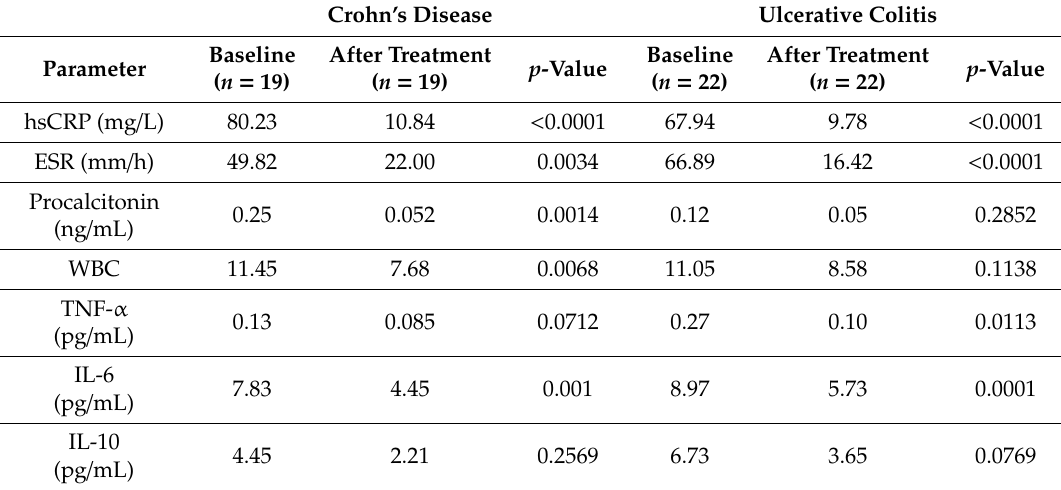
Table 2. Inflammatory bowel disease (IBD) patients—changes in inflammatory status during